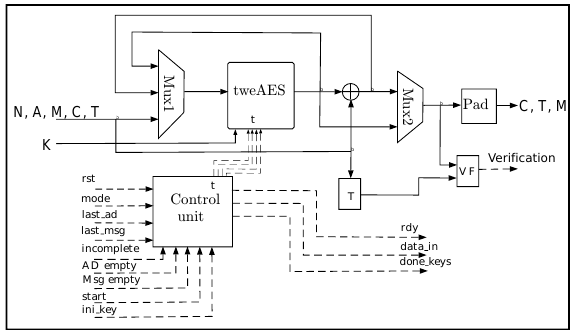
Figure 15: Hardware Architecture of